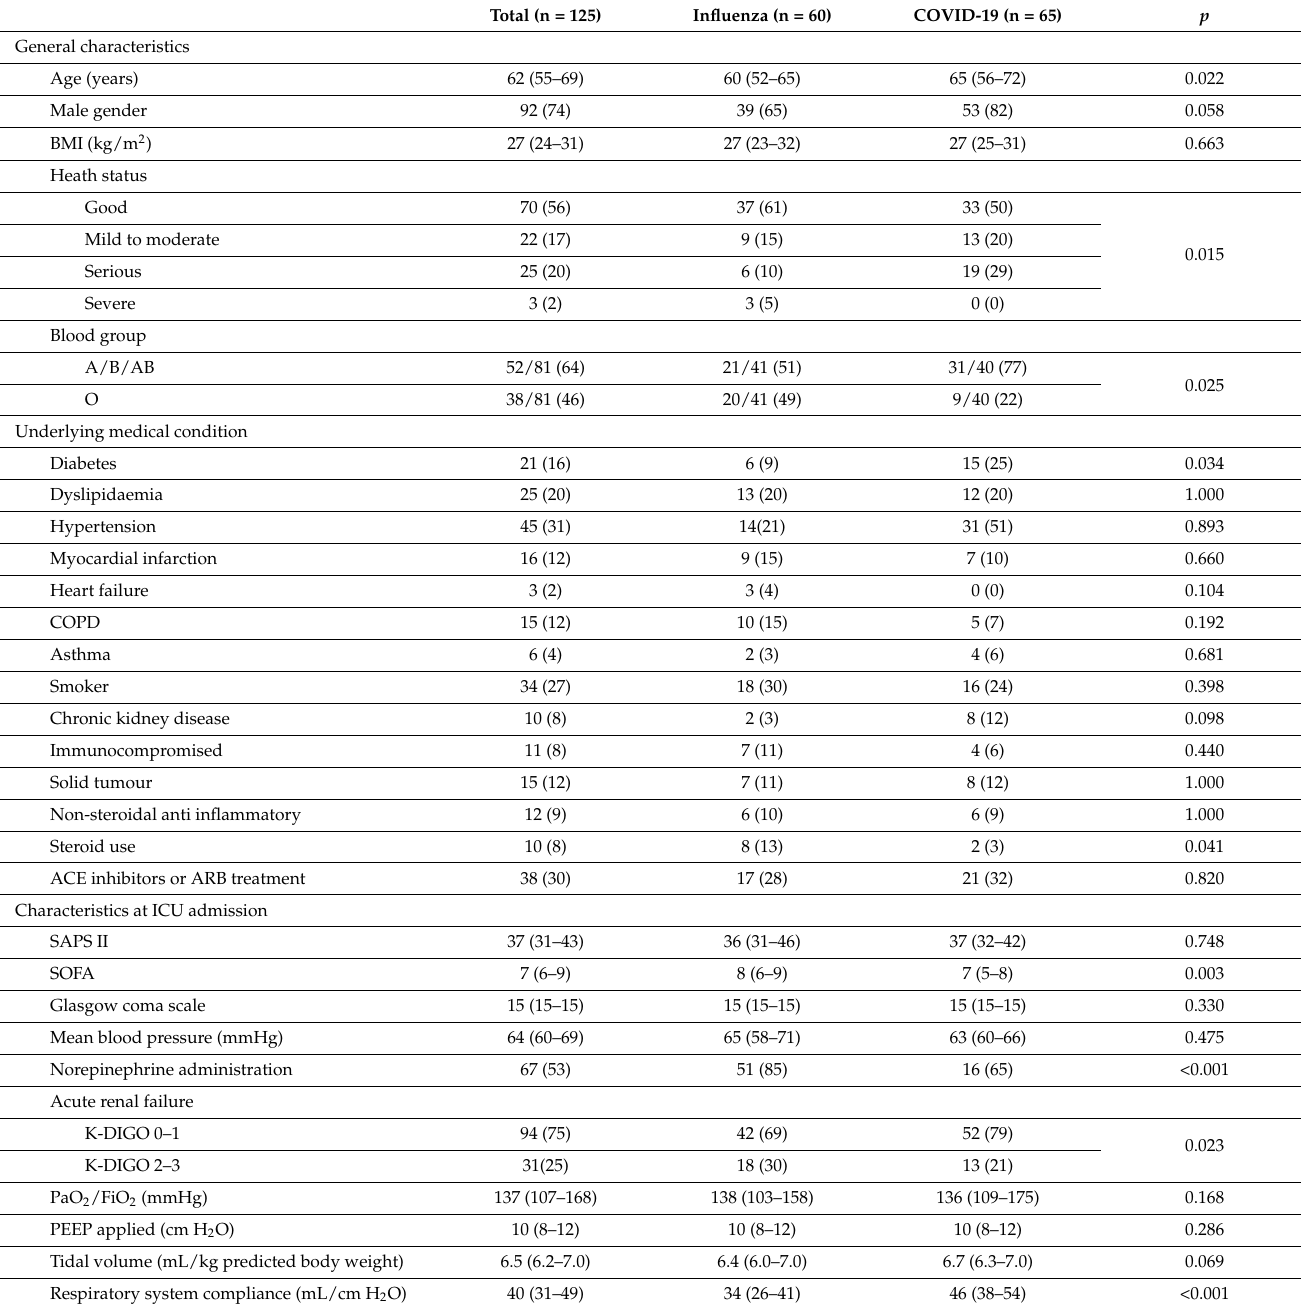
Table 1. Demographics and patient’s characteristics at ICU